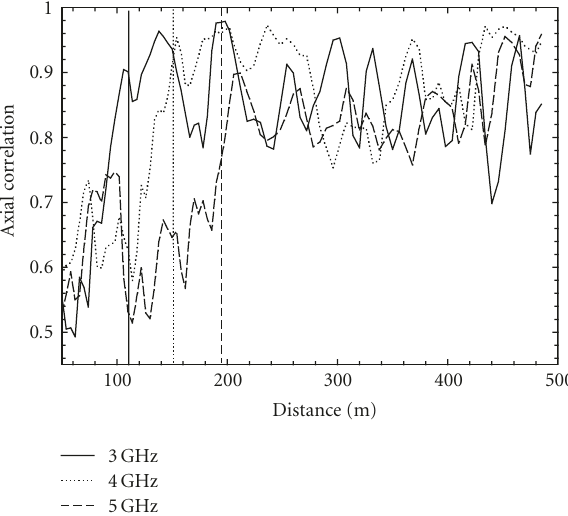
Figure 4: Path loss PL( f , d ) between two antennas for d = 50 m and path loss (cid:4) PL( f , d ) (cid:5) averaged over the transverse positions of the antennas and over 7 frequencies in a 10 MHz band.